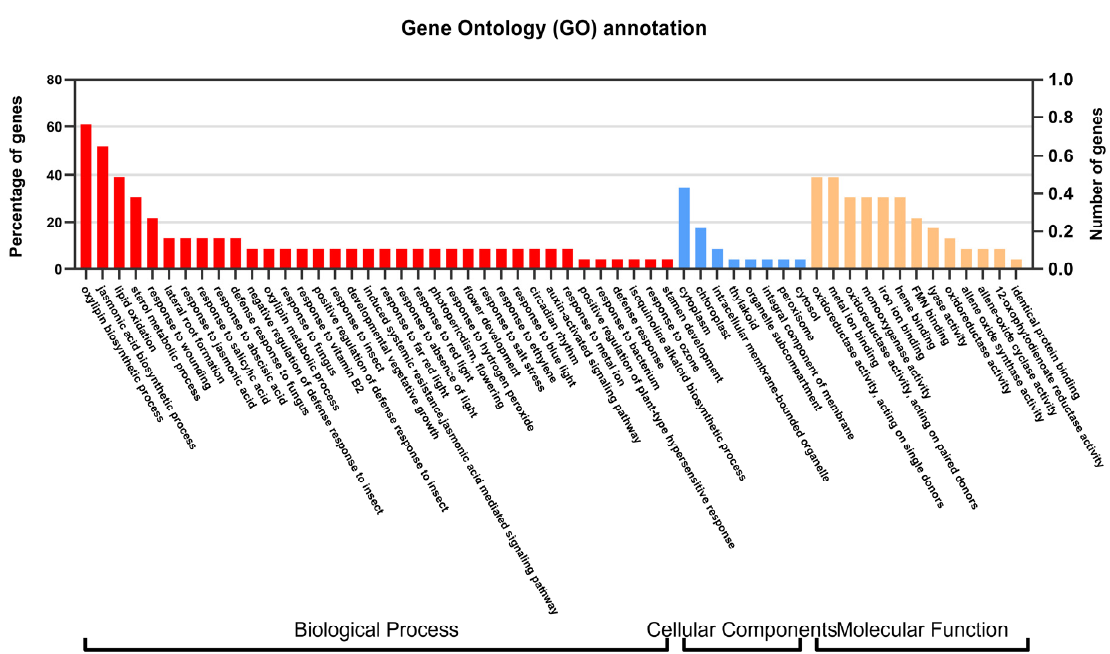
Figure 8. Gene Ontology (GO) annotation of JA biosynthesis related proteins. The y -axis on the right side indicates the number of genes in a category and on the left side indicates the percentage of a specific category of genes in the main category. The proteins were divided into three independent categories, namely biological process, cellular components, and molecular function.